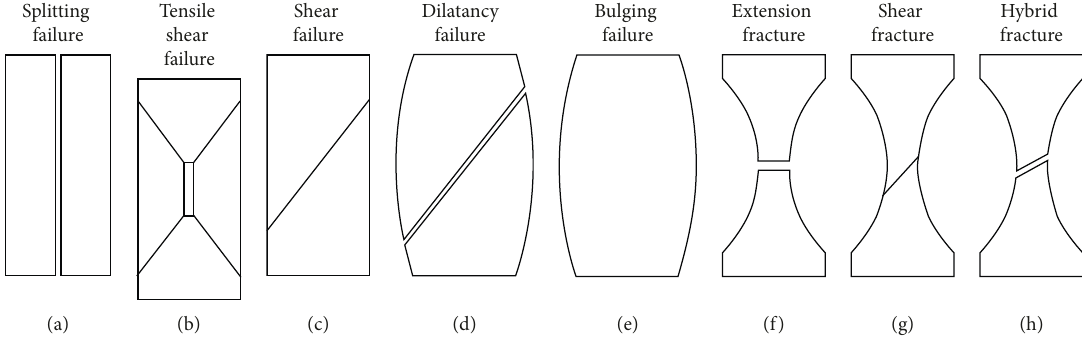
Figure 7: Eight failure modes of rock and soil under compression, from Tang et al. [65].